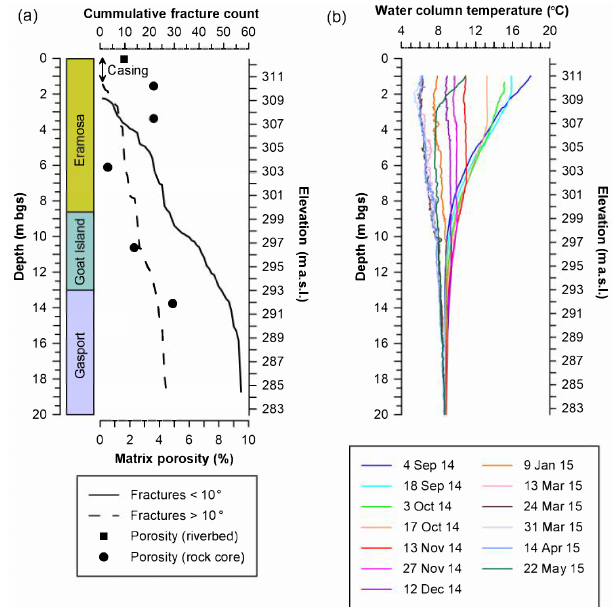
Figure 5. (a) Interpreted rock core from SCA1 (angled corehole plunging at 60 ◦ with an azimuth of 340 ◦ ). Fracture frequency and orientations were obtained using an acoustic televiewer log, while matrix porosity measurements were obtained from subsamples of the continuous core. (b) Corehole temperature profiles of the SCA1 Flute ™ sealed water